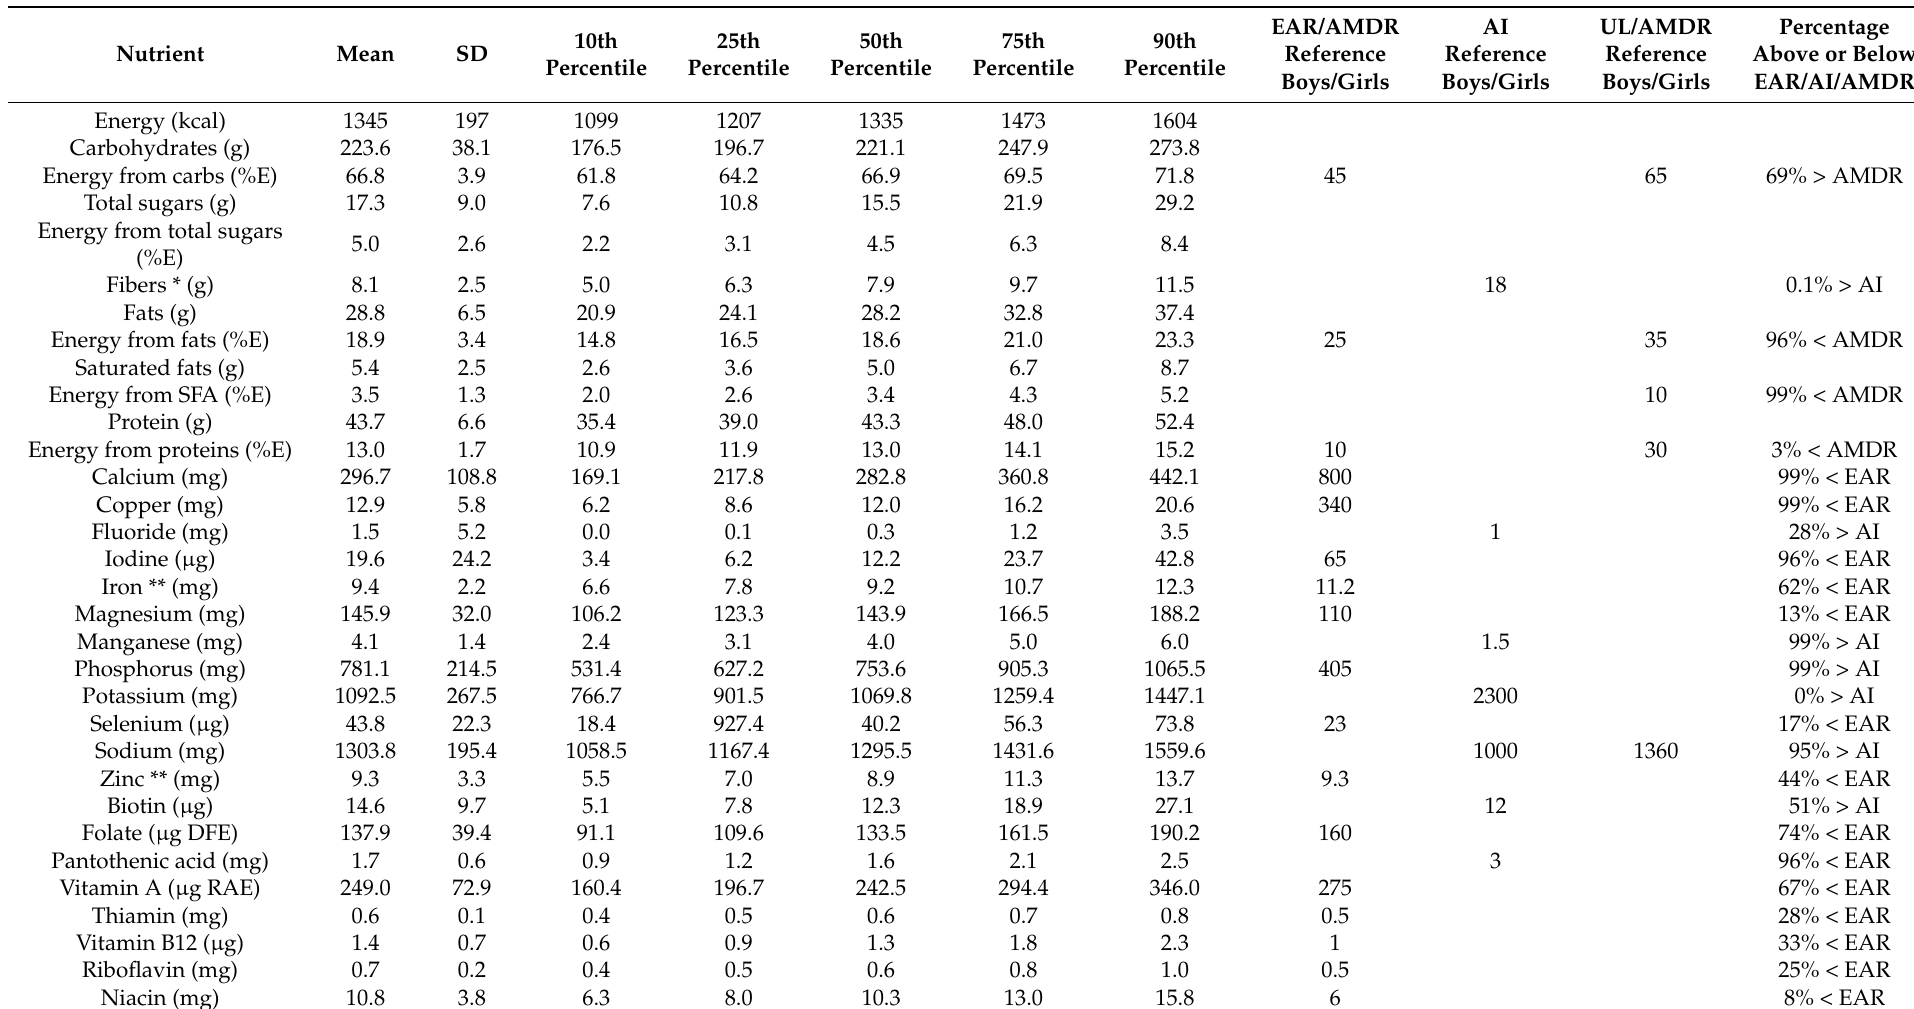
Table 2. Distribution of usual nutrient intakes and percentage of inadequacy in 4–8-year-old Nigerian